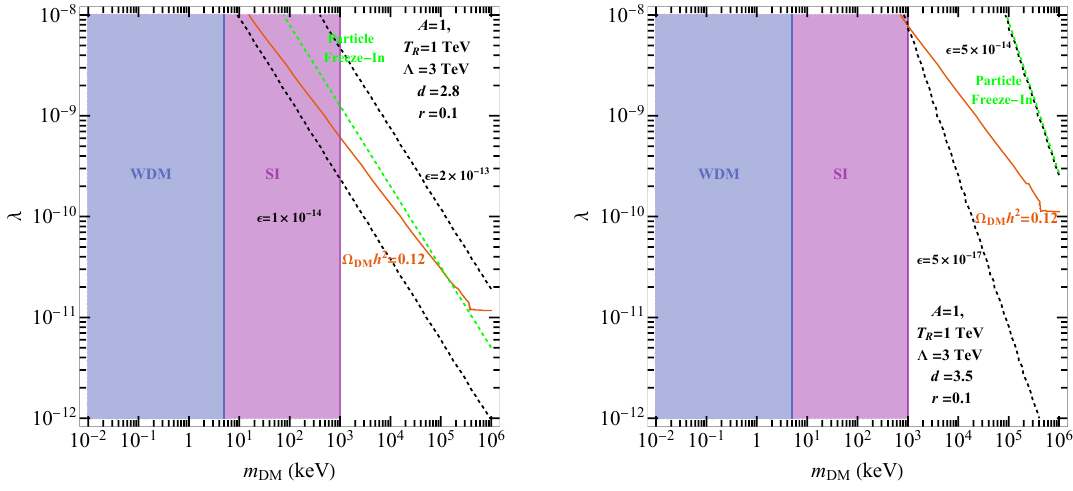
Figure 5 . The dark matter mass ( x -axis) and the SM-CFT mixing parameter, λ , ( y -axis) which reproduces the observed dark matter relic density (orange-red solid line). The two plots have dif- ferent scaling dimensions for our CFT operator; d = 2 . 8 (left) and d = 3 . 5 (right). For comparison, the green dashed line shows an estimate for the expected parameters which reproduces the observed relic density for the “usual” freeze-in with kinetic mixing parameter given by eq. (2.12) and the same relation between the dark photon mass and dark matter mass [14]. The blue shaded region corresponds to the region of parameter space excluded by the warm dark matter bound. The purple shaded region is excluded by DM self-interaction bound coming from the observation of the bullet- cluster. The dashed curves show contours of constant kinetic-mixing parameter, (cid:15) , with g s